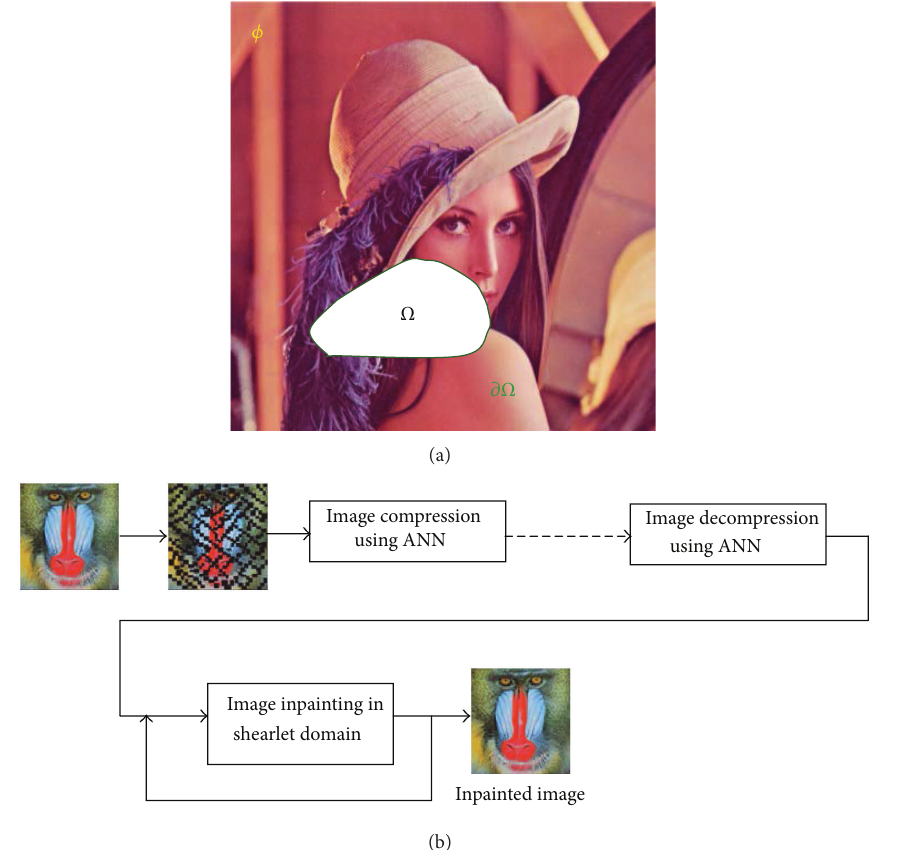
Figure 5: (a) Illustration of the inpainting problem. (b) The simplified architecture for image coding with